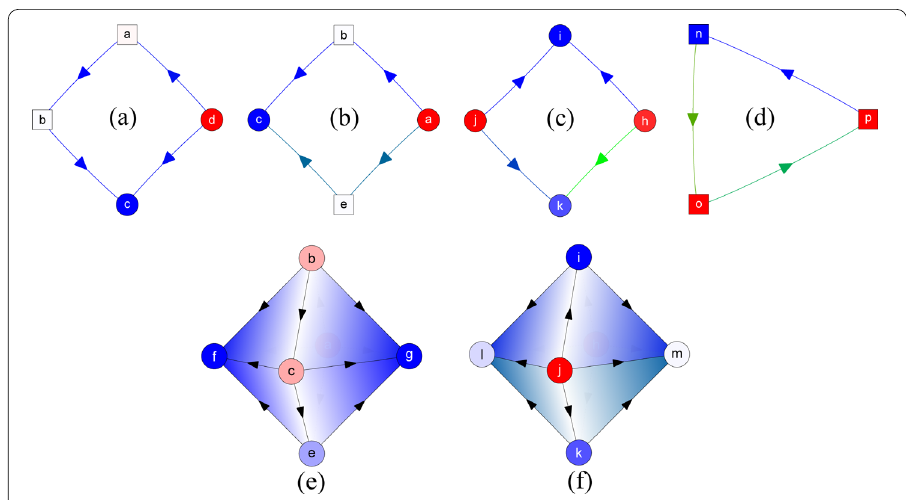
Figure 8 Cycles in the toy example. Figures ( a )–( d ) show the 1-cyles for the toy example. The nodes are colored red if the sum of the weights of all outgoing edges is larger than that of incoming edges, and blue otherwise. Deeper colors represent larger numbers. The shape of a node indicates whether it is a source or sink (circle) or not (square). The edges follow a coloring spectrum of red for the smallest edge weight in the network to blue for the largest. Figures ( e )–( f ) show the two 2-cycles in the toy example. The directed triangles are colored according to the weight of the edge that completes the